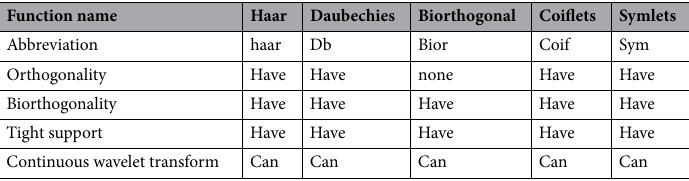
Table 1. Common wavelet base statistics.